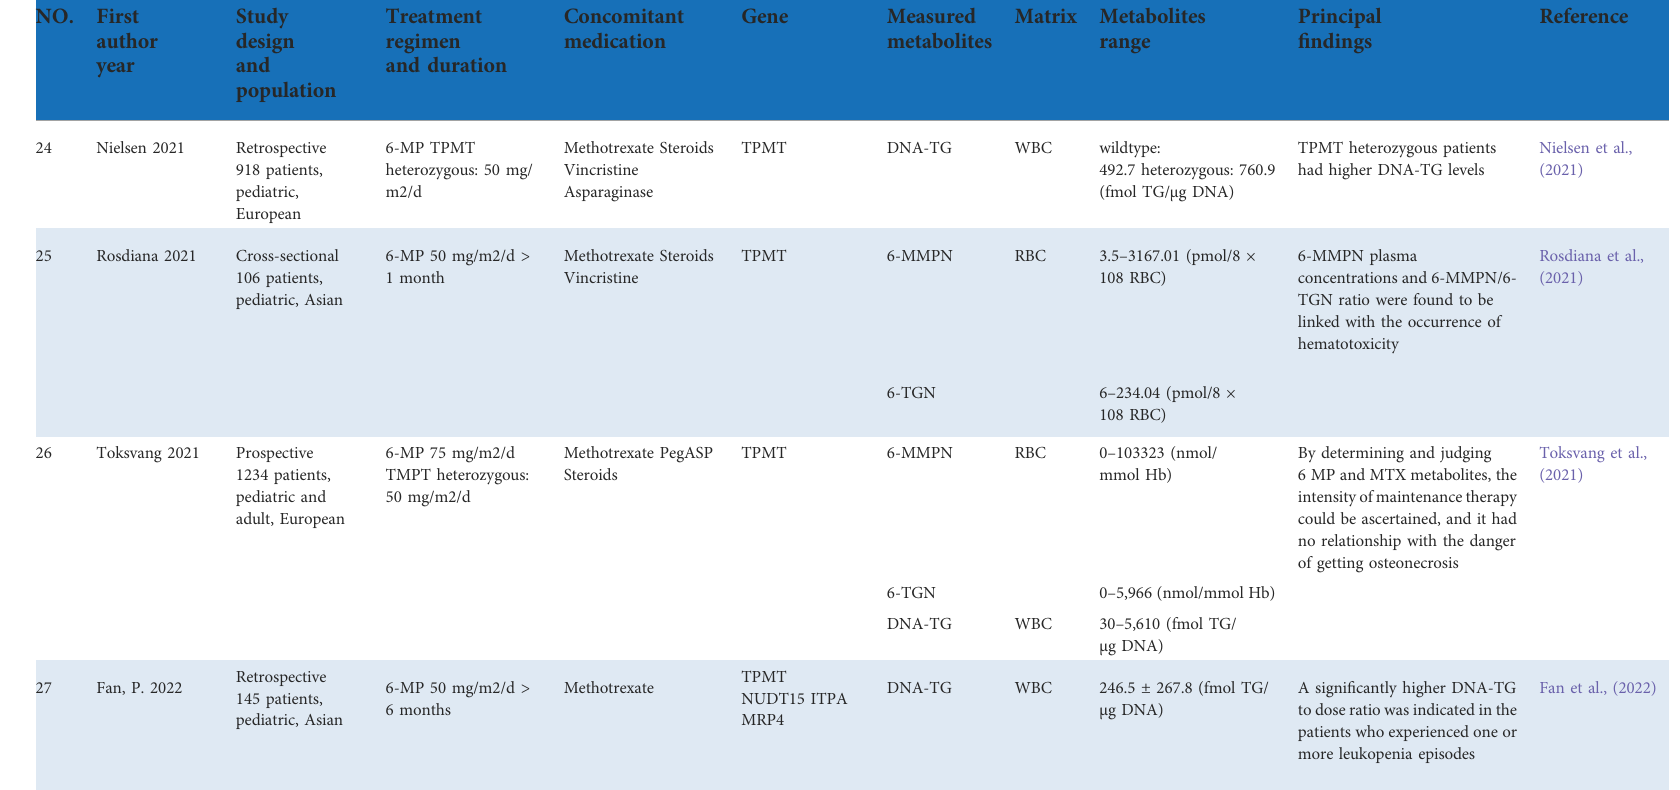
ADR, adverse drug reaction; PegASP, Pegylated-asparaginase; GI, symptoms: gastrointestinal symptoms; VOD, vena-occlusive disease; SR, standard risk; IR, intermediate risk; WT, wild-type; HT, carrier of one variant allele; 6-MP, 6-mercaptopurine; TPMT,thiopurineS-methyltransferase;NUDT15,Nudixhydrolase15;6-TGN,6-thioguaninenucleotides;6-MMPN,methyl-thioIMP;DNA-TG,DNA-incorporatedthioguanine;ITPA,inosinetriphosphatepyrophosphatase;RBC,redbloodcells;WBC, white blood